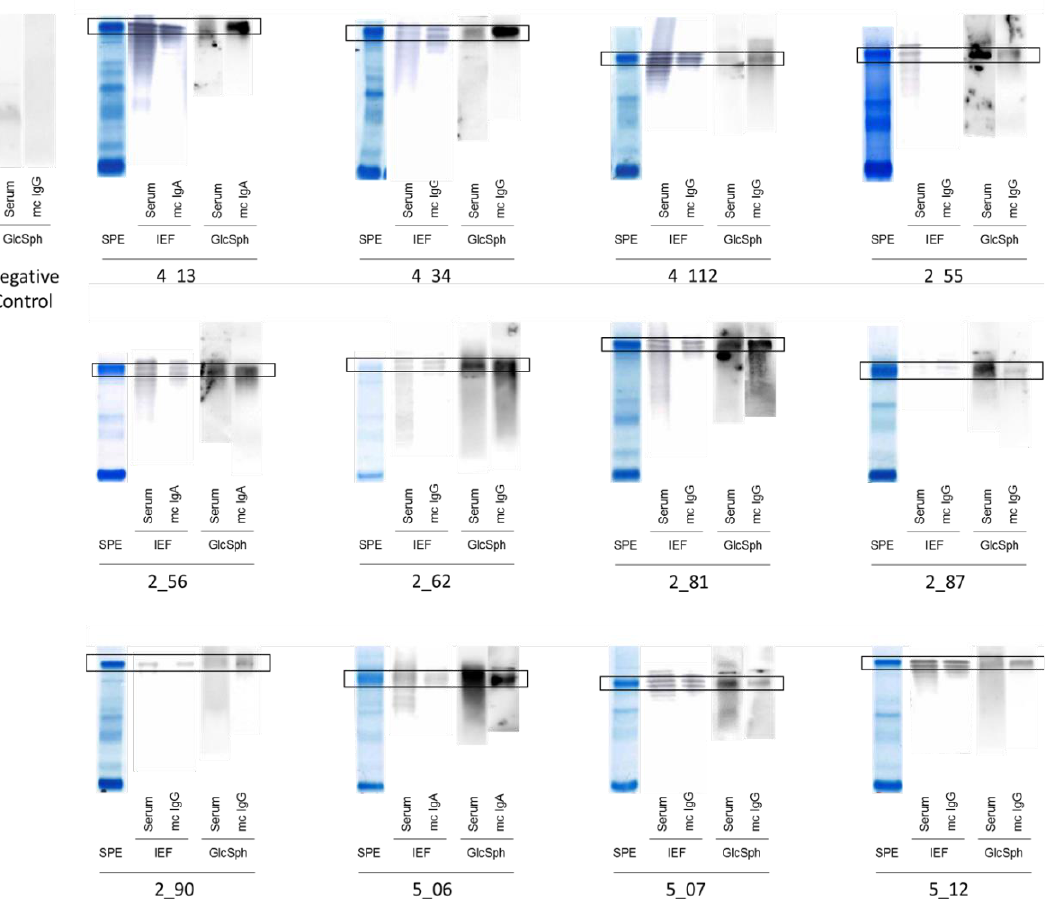
Figure 1. Glucosylsphingosine (GlcSph)-reactivity of serum Igs and monoclonal Igs obtained for patients with monoclonal gammopathy of undetermined significance (MGUS). Measurement of Ig concentration, separation of monoclonal Igs from other Igs, and verification of purity were performed as published [5 – 7,14,15]. Purification starts with the separation of serum proteins with high resolution agarose gel electrophoresis (SAS-MX high resolution, Helena Biosciences, Gateshead, UK). Then, the monoclonal Ig is cut from the gel and eluted in phosphate buffer saline (PBS). The purity of the monoclonal Ig preparation is verified by isoelectric focusing (IEF) on an agarose gel (pH 3 – 10) followed by blotting and immuno-revelation by an anti-human IgG γ chain or anti-IgA α chain antibody labeled with peroxidase. For GlcSph-specific immunoblotting, polyvinylidene fluoride (PVDF) membranes are incubated for 90 min in 100 μg/mL of GlcSph in 0.1 M sodium bicarbonate, rinsed in PBS and 0.1% Tween 20 detergent, and then blocked with 5% bovine serum albumin (BSA) in PBS and 0.1% Tween 20. Samples of serum and purified monoclonal Ig are submitted to agarose gel electrophoresis, and then the gels are blotted onto the GlcSph-saturated membranes by diffusion blotting during 12 min. After blocking with 2.5% BSA in PBS and 0.1% Tween 20, membranes are incubated with anti-human IgG or IgA horseradish peroxidase (HRP)-conjugated secondary antibody, washed, and revealed by chemiluminescence. Signals corresponding to the patient’s monoclonal Ig are encircled in black. The negative control is a patient with no GlcSph-reactive Ig in serum. SPE = Serum protein electrophoresis; Mc Ig = purified monoclonal Ig. The GlcSph-reactivity of serum Igs and monoclonal Igs obtained for 12 other MGUS patients are shown in Figure S2.